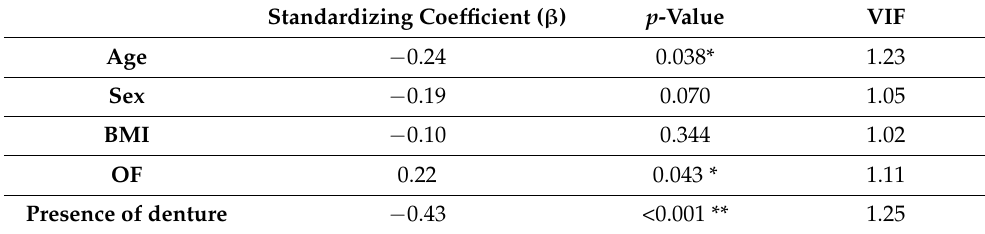
Table 4. Multiple regression analysis with jaw-closing force as dependent variables (n =